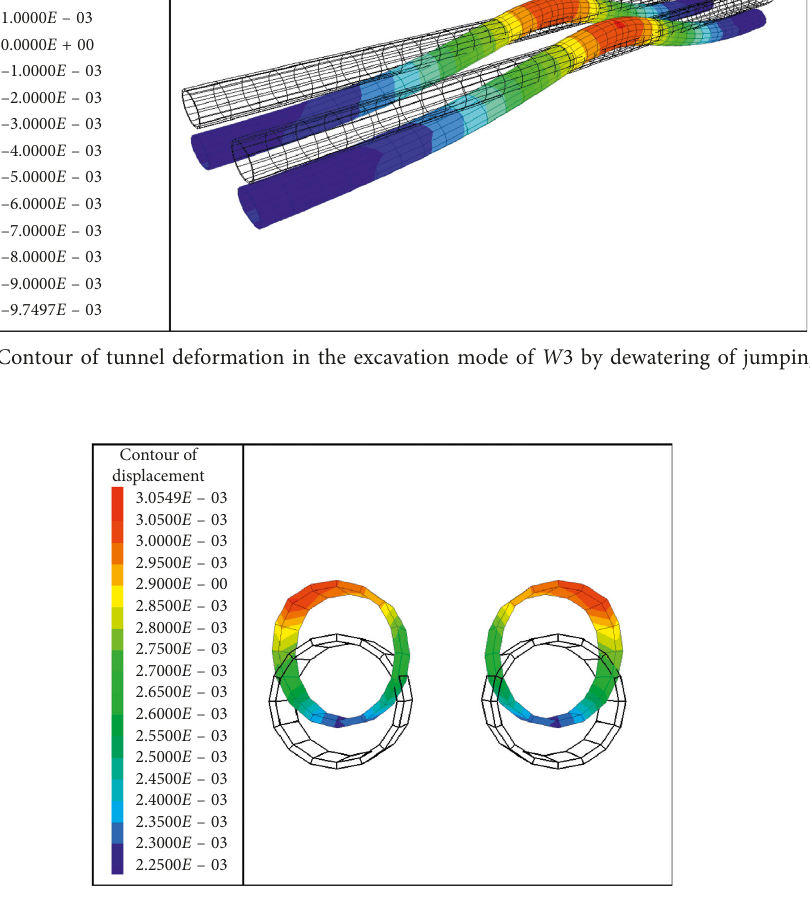
Figure 17: Front view of pipe piece deformation contour at Y �